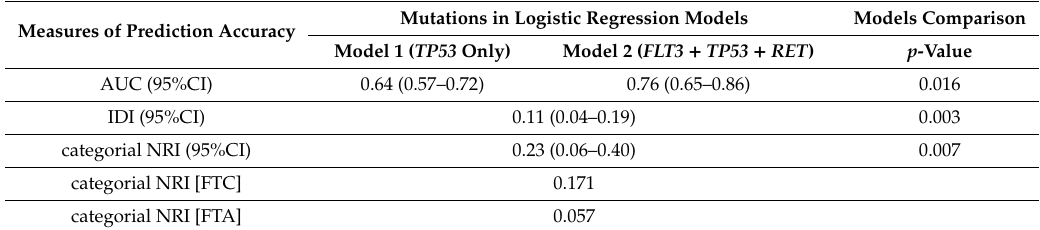
Table 3. The comparison of two models of FTC and FTA prediction.